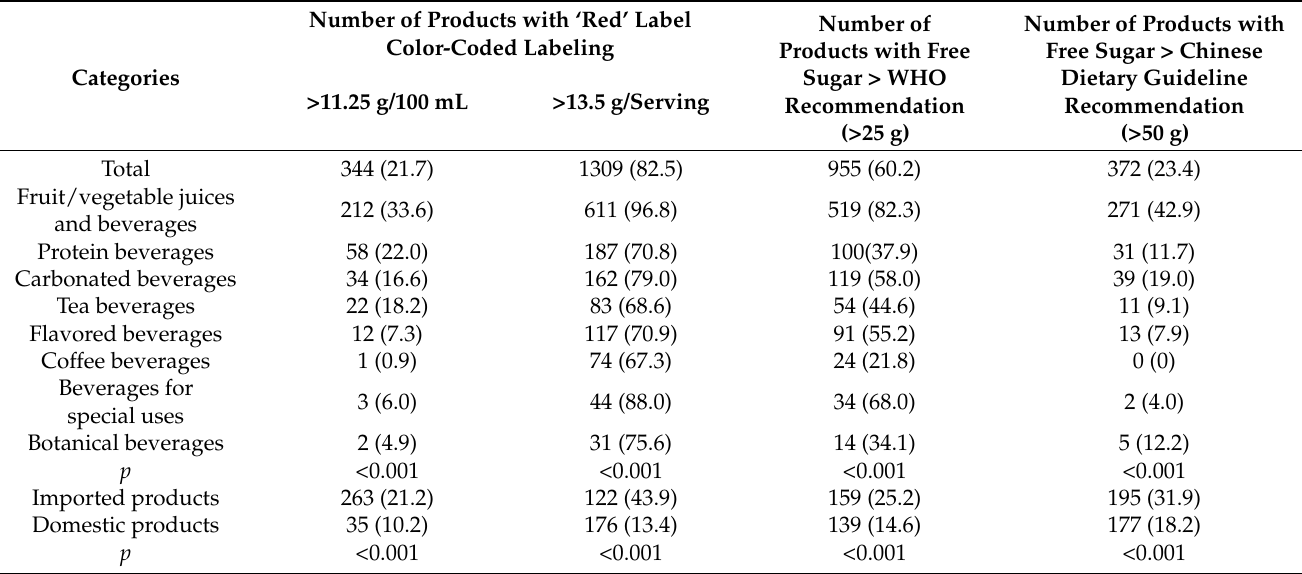
Table 2. Description of sugar in different beverages according to different recommendations ( n ,